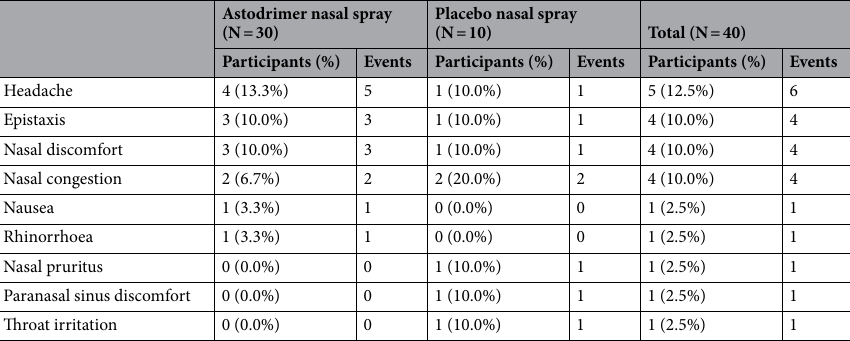
Table 3. Incidence of treatment emergent adverse events considered potentially